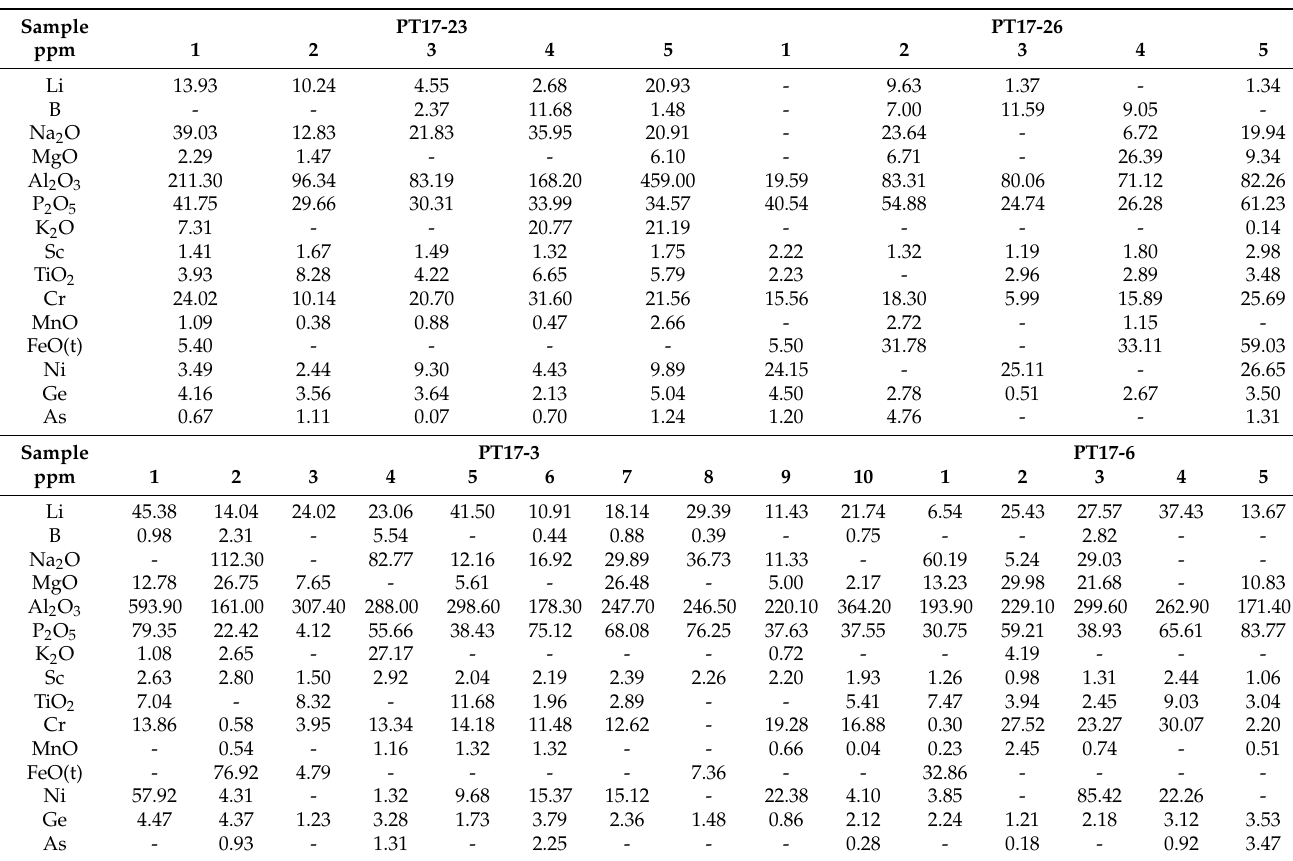
Table 3. In situ trace element concentrations of quartz in the Piaotang